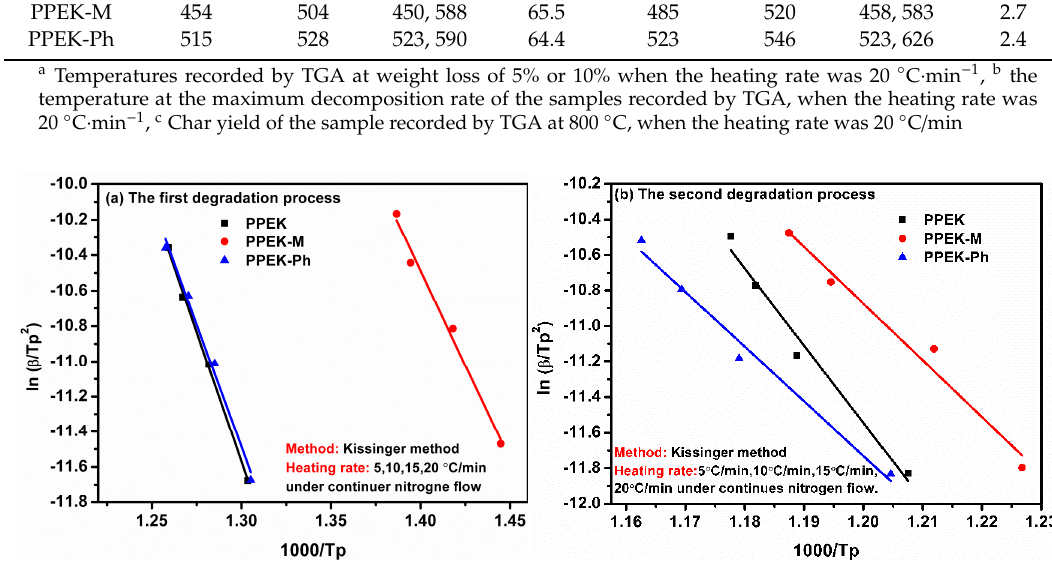
Figure 5. Linear plots of β / Tp2 against 1000 / Tp for the polymers, according to Kissinger’s method. where β is the heating rate (°C min − 1 ), Tp is the temperature corresponding to the inflection point in the thermal degradation curve of the maximum of the DTG curves (°C). Table 4. Activation energy of the PPEKs determined by Kissinger's method.